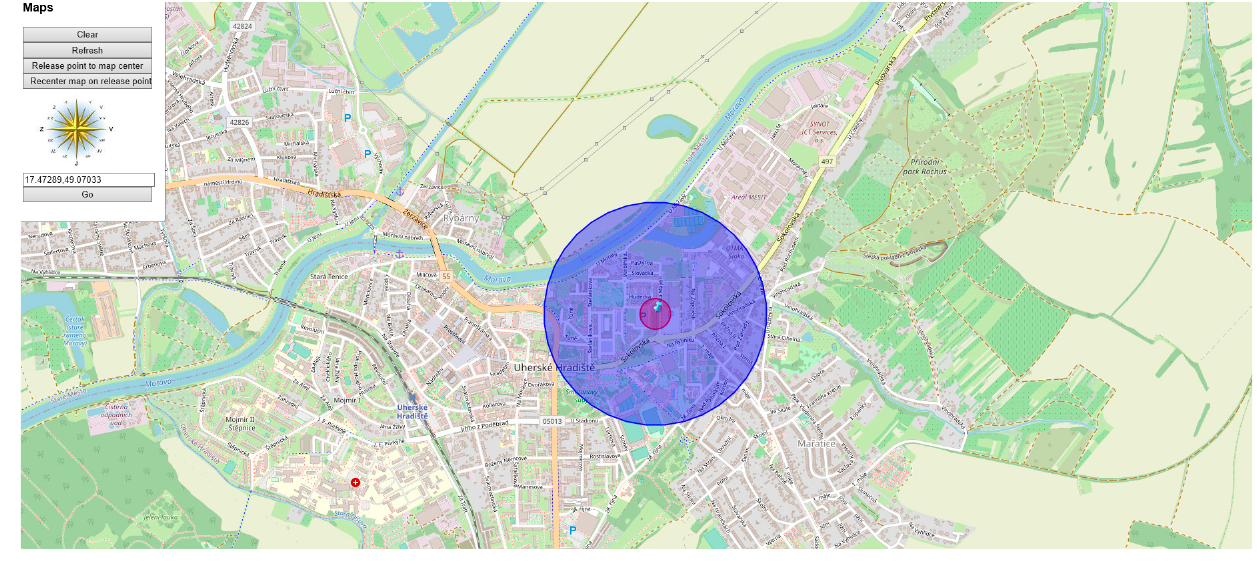
Figure 9. TerEx output.